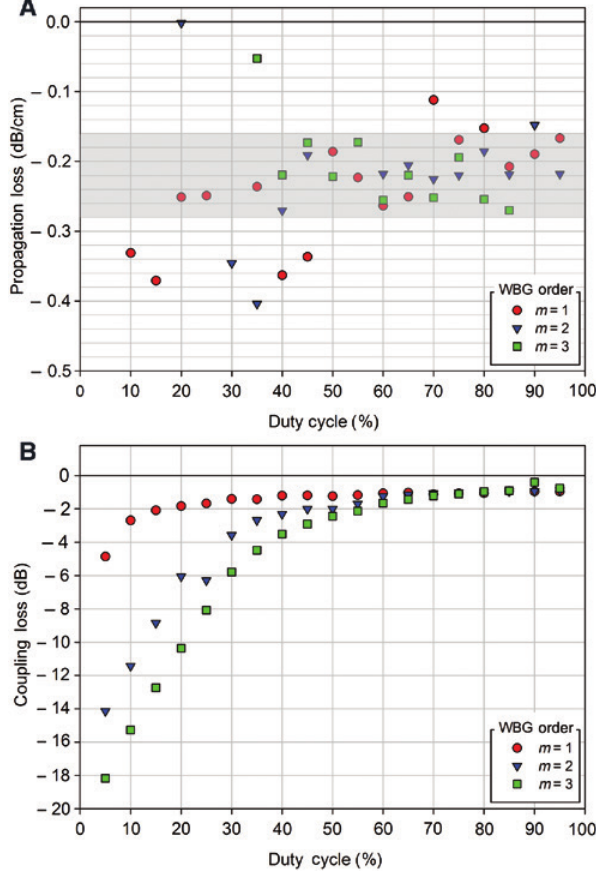
Figure 11: (A) PL and (B) CL of C-band WBGs calculated from three different length samples using the cut-back method.